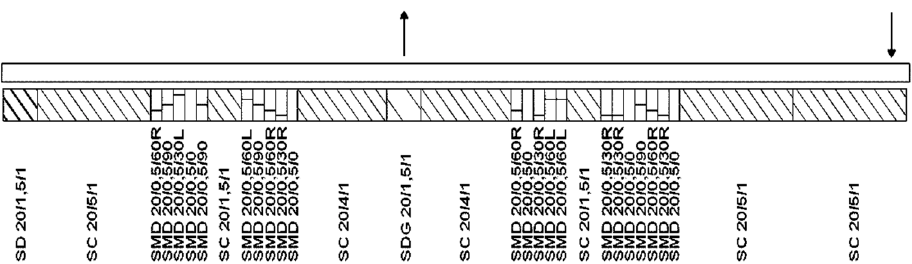
Figure 1. Screw configuration applied during extrusion grinding of brewers’ spent grain (BSG) (SMD kneading element, SC, SD and SDG types of conveying elements. The segments were named according to the Zamak Mercator specification).